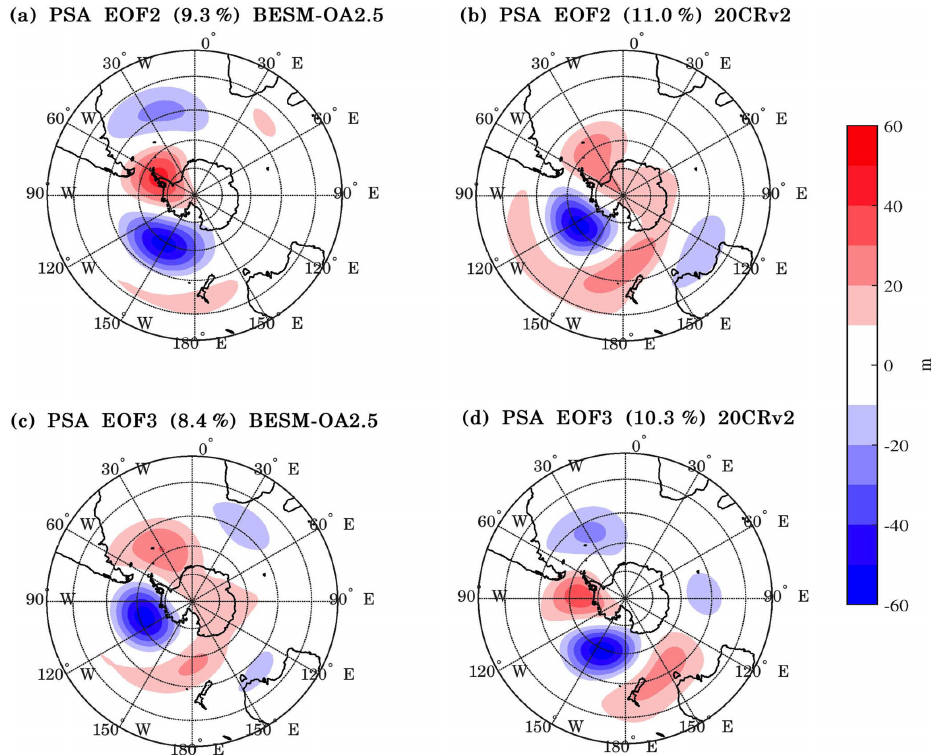
Figure 23. (a) The second and third EOF modes of the monthly mean 500hPa geopotential height field for the Southern Hemisphere (20–90 ◦ S) for BESM-OA2.5 (b) and 20CRv2 reanalysis. The results are shown as the 500hPa geopotential height regressed onto the corresponding normalized PC time series (meters per standard deviation) over the period 1950–2005. The percentages of the variance explained by each EOF are indicated in the titles of the figures. The contour interval is 10m.